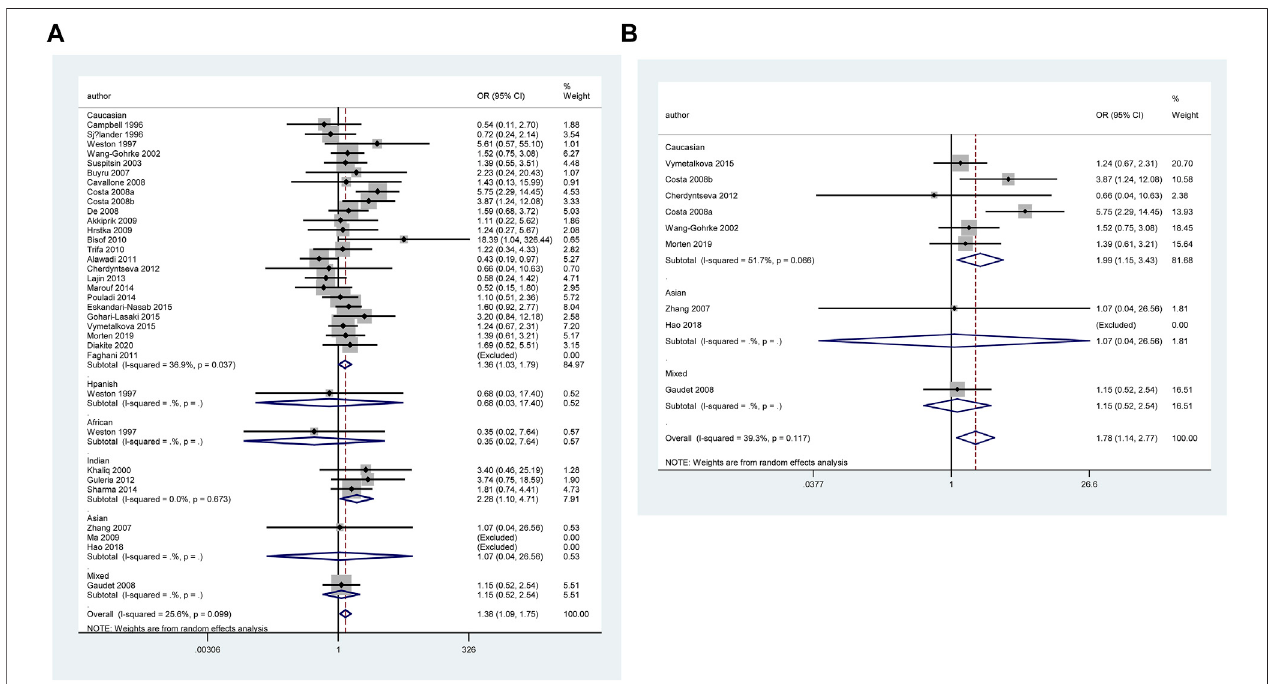
FIGURE 5 | Forest plot of the association between TP53 IVS3 16 bp polymorphism and BC risk in ethnicity subgroup analysis (GG vs. CC + CG) [ (A) : Overall analysis; (B) : Sensitivity